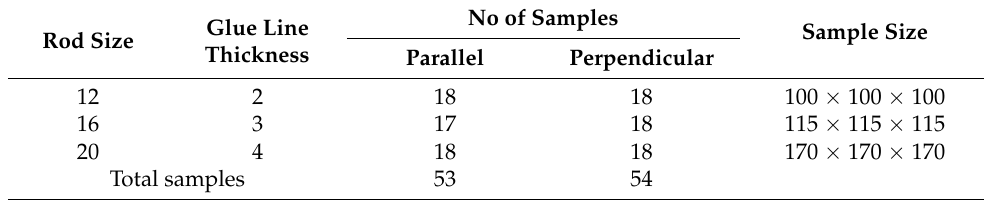
Table 1. Specimens Table 1. Specimens Preparation.